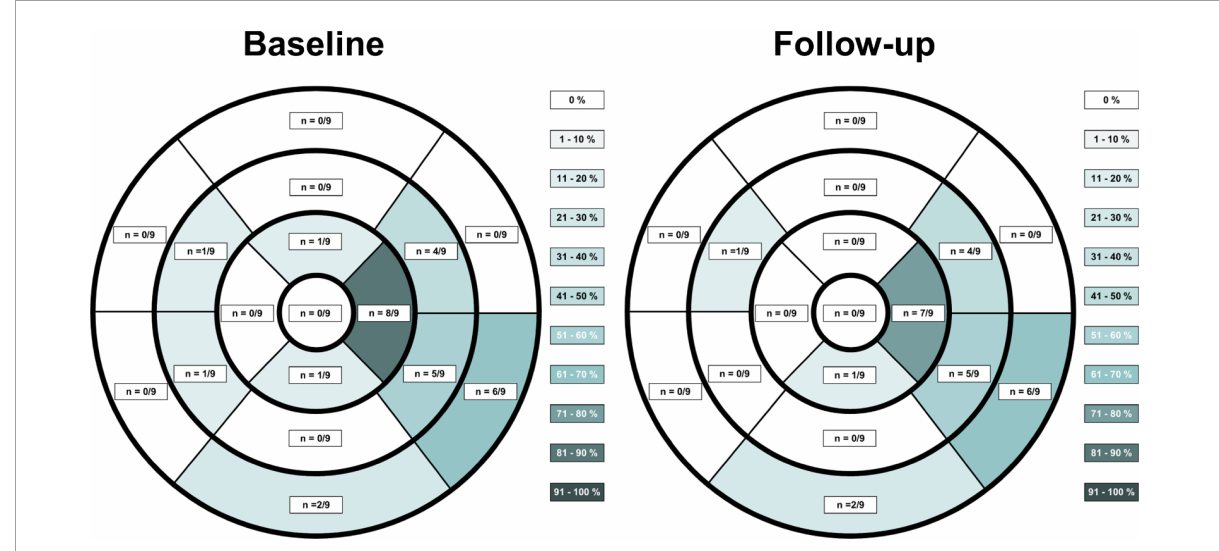
FIGURE1 Late gadolinium enhancement (LGE) distribution on CMR in patients suffering from vaccine associated myocarditis at acute baseline imaging and at follow-up according to the American Heart Association 17-segment heart model. LGE extent was reduced on follow-up imaging, although LGE findings were still discernable at most previous